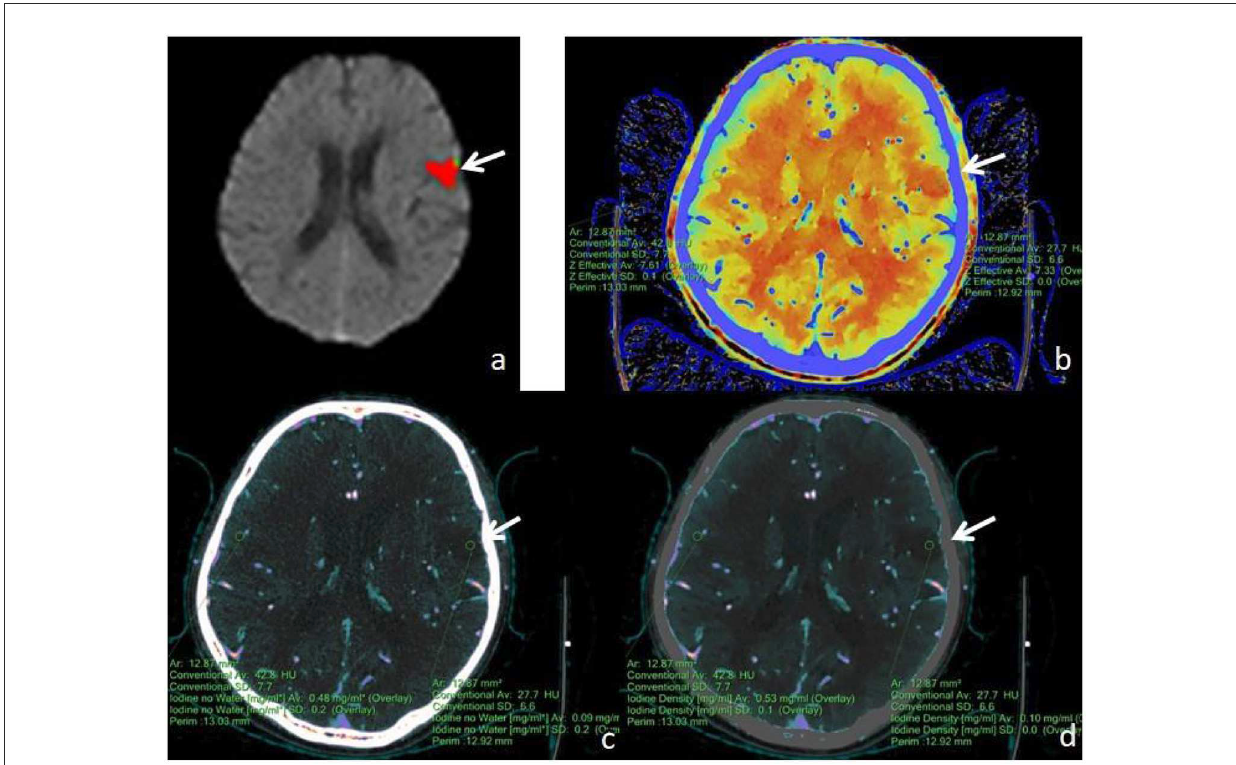
FIGURE4 A male, 62 years old, presented with speech disorder and right-sided limb movement for 12h. (a) F-STROKE automated perfusion analysis software showed left temporal lobe AIS with CBF < 30% = 8.9mL and Tmax > 6S = 12.1mL. (b–d) Zeff maps, iodine density maps, and iodine–no water maps, respectively, with arrows indicating ischaemic areas in the left temporal lobe. (b) A Zeff value of about 7.33 was measured in the ischaemic area in the left temporal lobe, and a corresponding Zeff value of about 7.61 was measured in the contralateral non-ischaemic area. (c) An absolute iodine value of approximately 0.09 mg/mL was measured in the ischaemic area of the left temporal lobe, and a corresponding absolute iodine value of approximately 0.48 mg/mL was measured in the contralateral non-ischaemic area. (d) An iodine density value of approximately 0.10 mg/mL was measured in the ischaemic area of the left temporal lobe, and a corresponding iodine density value of approximately 0.53 mg/mL was measured in the contralateral non-ischaemic